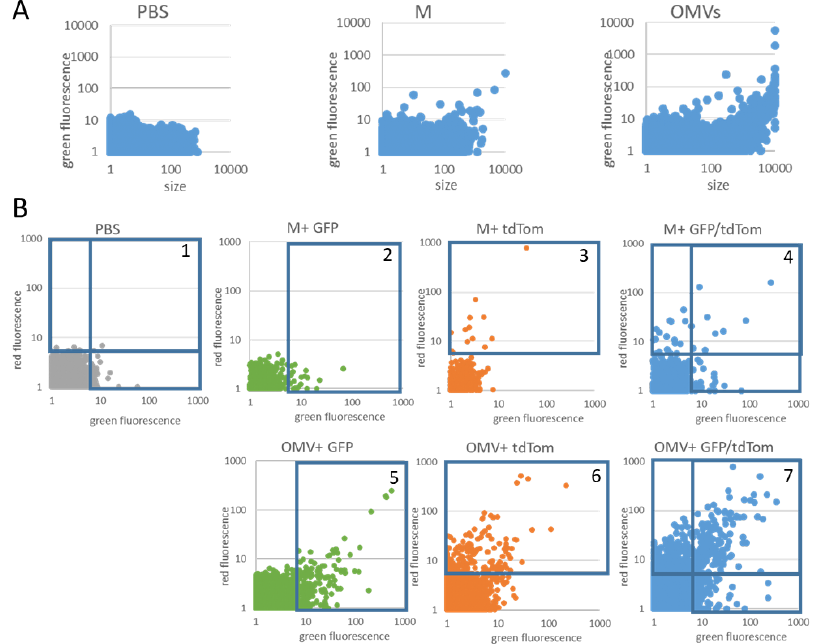
Figure 5. Double painting—vesicles and gates. OMV preparations modified with two different fluorophore proteins were analyzed by nanovariant flow cytometry. ( A ) Particles were measured and counted (see also Table 4) to show a significant number of events in the PBS or medium (M) controls. These are inherently not OMVs, but salt or protein aggregates or nanobubbles. A different size distribution is observed in the OMV-containing samples. ( B ) Images 1 to 7 show the distribution of gates for the different samples. For double-stained samples (4 and 7) the following two modalities are feasible: red OR green; red AND green. For quantitative data, see Figure